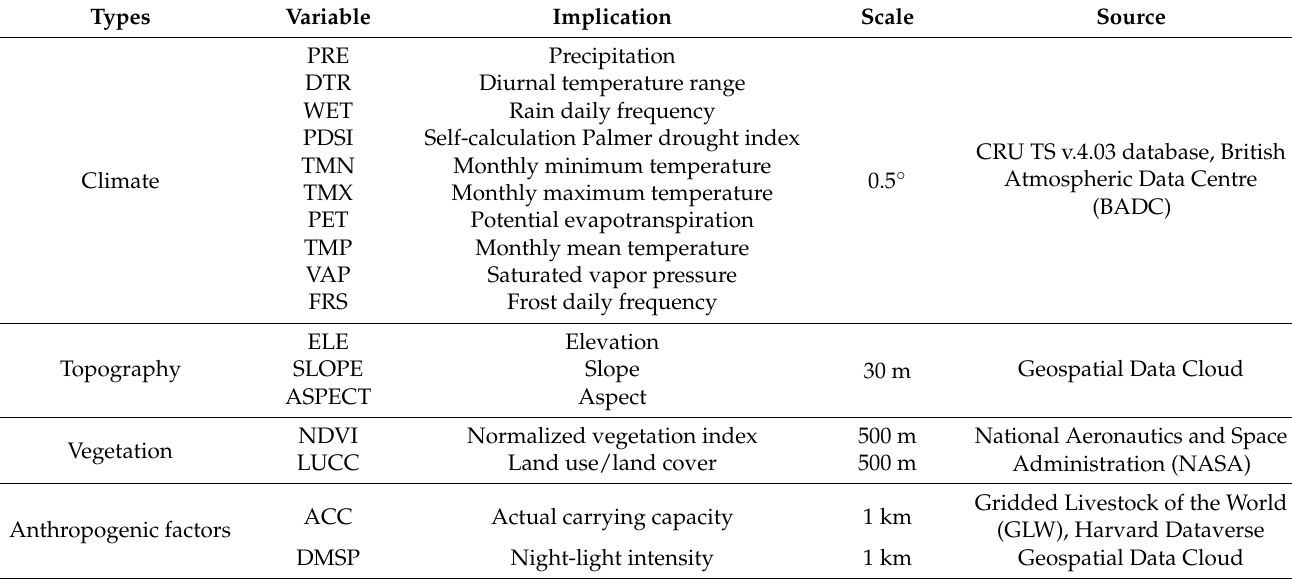
Table 1. Explanatory variables selected to predict the probability of wildfire